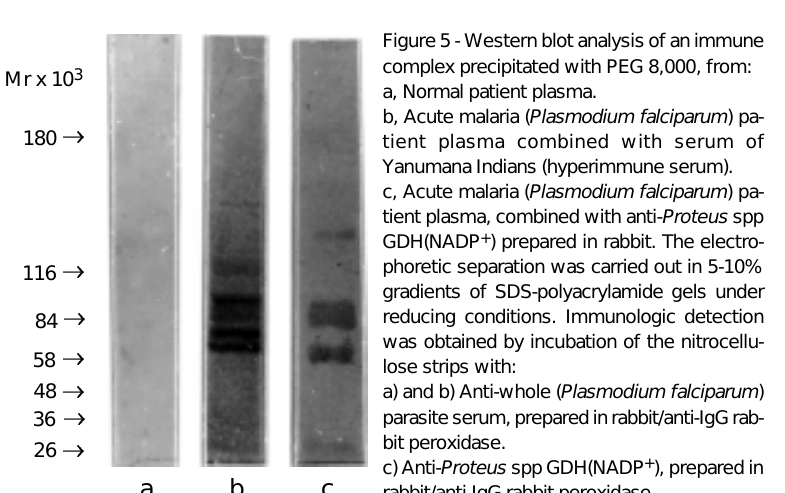
Figure 5 - Western blot analysis of an immune complex precipitated with PEG 8,000, from: a, Normal patient